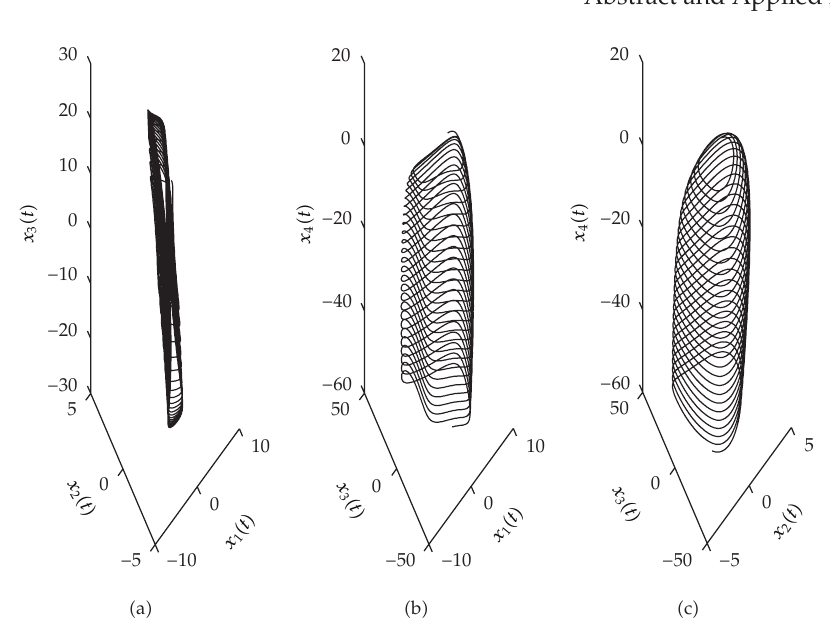
Figure 3: Three-dimesional phase plots for the hyperchaotic Chua